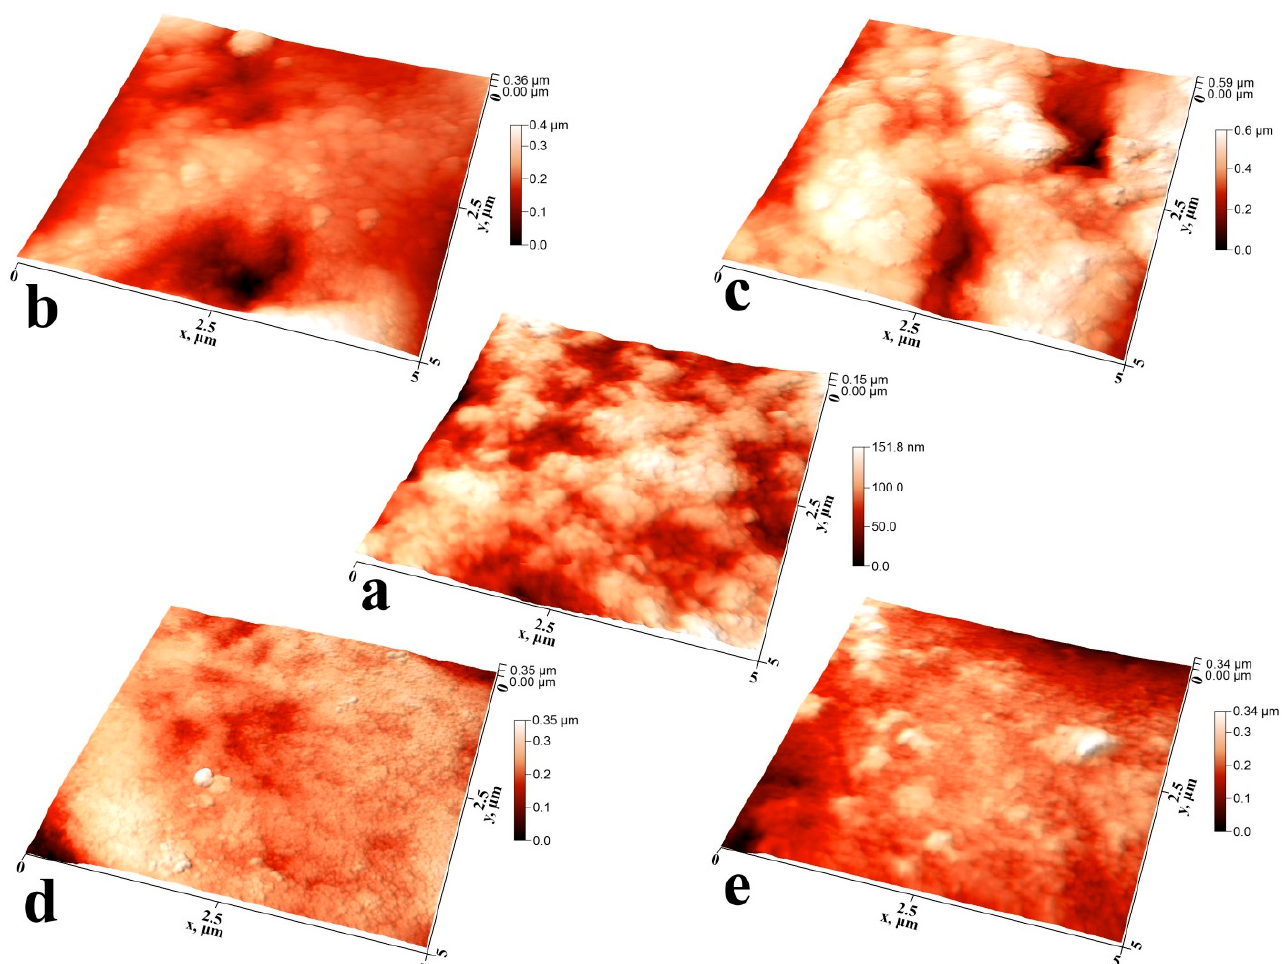
Figure 3. Three-dimensional AFM images of typical surface areas of mineralized tooth tissue samples: ( a ) healthy tooth enamel without treatment (sample N1); ( b ) without pretreatment and with subsequent mineralization (sample N2); ( c ) after surface pretreatment with H 3 PO 4 and subsequent mineralization (sample N3); ( d ) after surface pretreatment with Ca(OH) 2 and subsequent mineralization (sample N4); ( e ) after surface pretreatment with Ca(OH) 2 and an amino acid booster, with subsequent mineralization (sample N5).